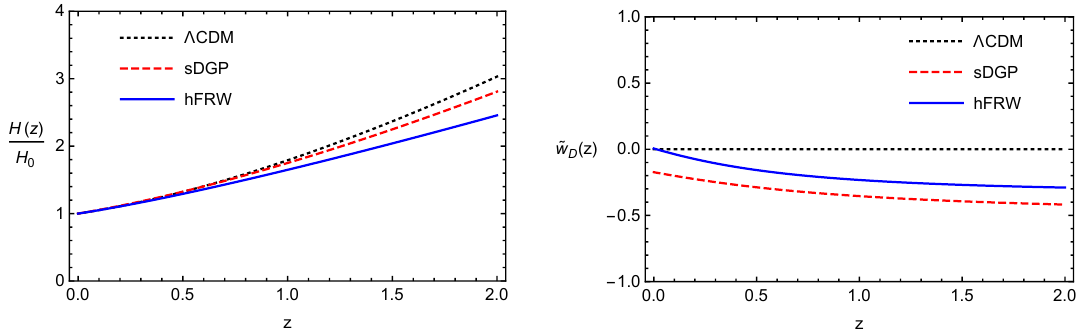
Figure 1 . Left: the reduced Hubble parameters H ( z ) =H 0 in terms of the redshift z in various models. Right: the evolution of state equations ~ w D ( z ) in terms of the redshift z in various models. (cid:3)CDM: the plotting functions are in (3.43) and (3.48), with the parameters in (2.11); sDGP: the plotting functions are in (3.44) and (3.47), with the (cid:12)tting parameter (cid:10) M = 0 : 21 in [32]; hFRW: the plotting functions are in (3.45) and (3.48), with a special choice of the parameters (cid:10) M = (cid:10) B , (cid:10) I = 3 ((cid:10) D (cid:0) (cid:10) B ), along with the values in 2